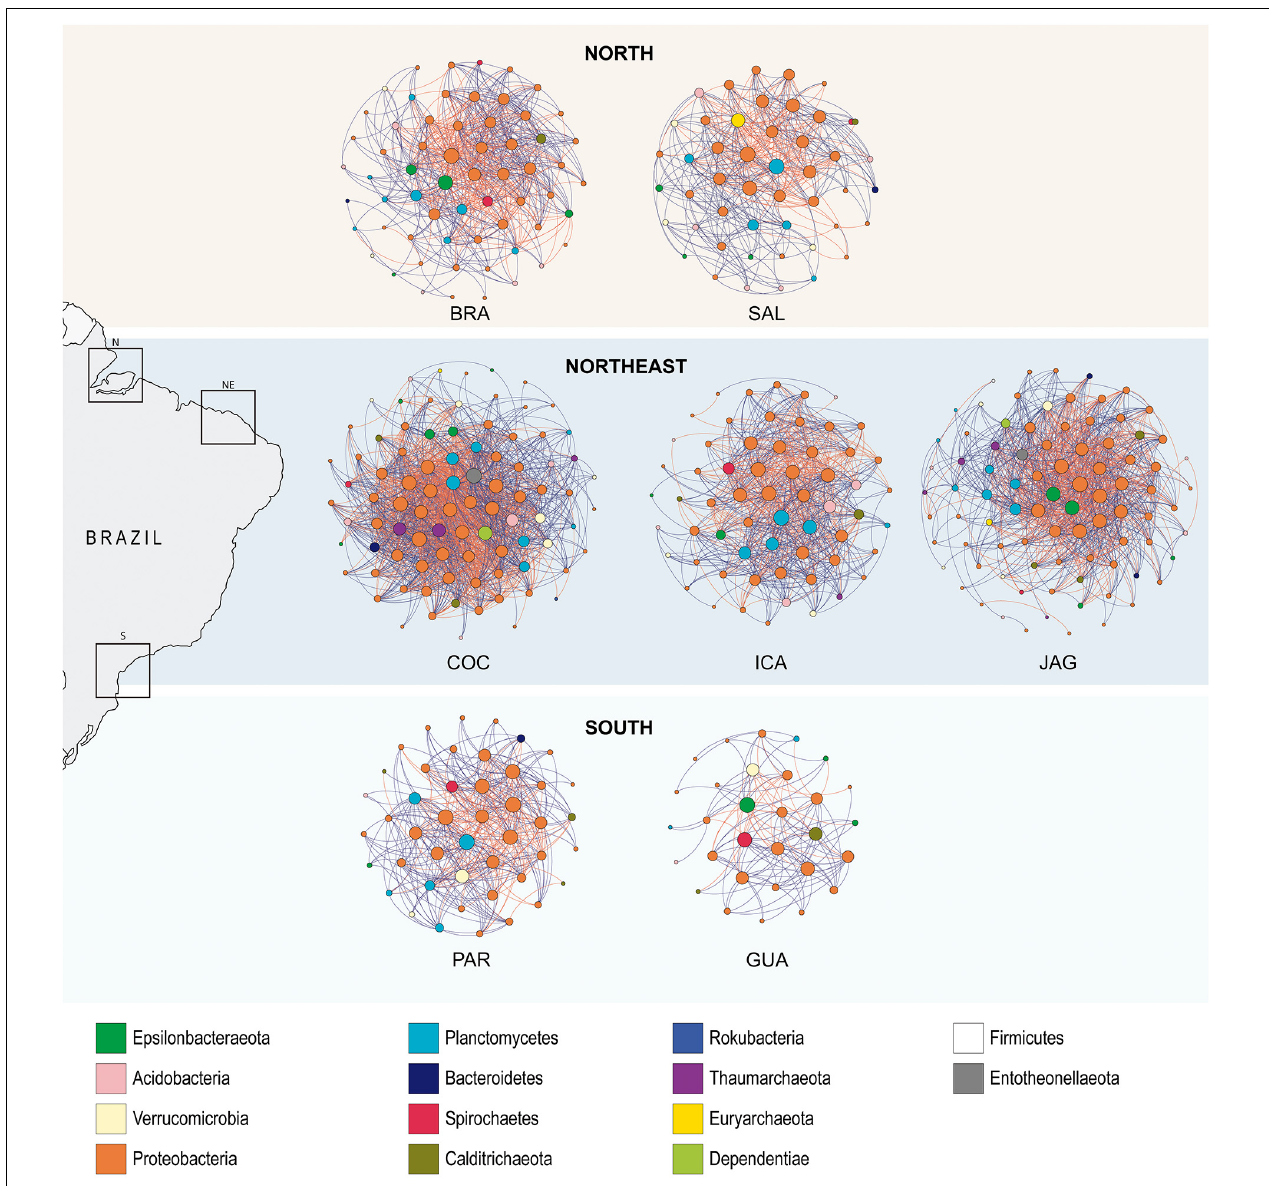
FIGURE 7 | Co-occurrence network based on correlation analysis. A connection stands for a Spearman’s correlation with magnitude > 0.7 (positive correlation–blue edges) or < –0.7 (negative correlation–red edges) and statistically significant ( P < 0.01). The size of each node is proportional to the number of connections (degree). Each node was labeled at the phylum